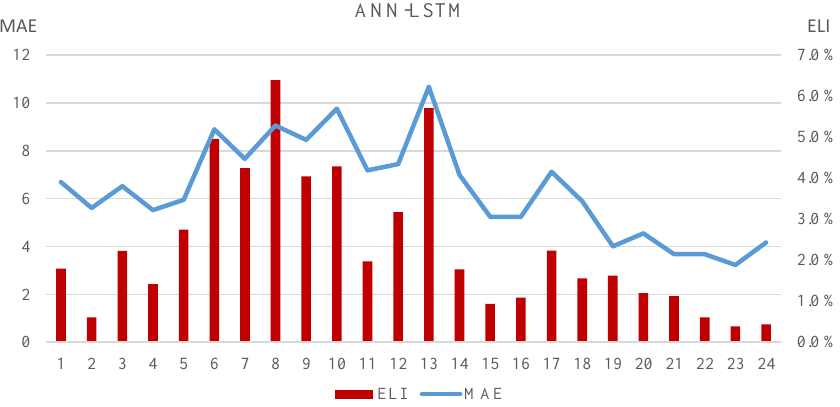
Figure 3. MAE and ELI Results of the ANN-LSTM Model for 24 Forecast